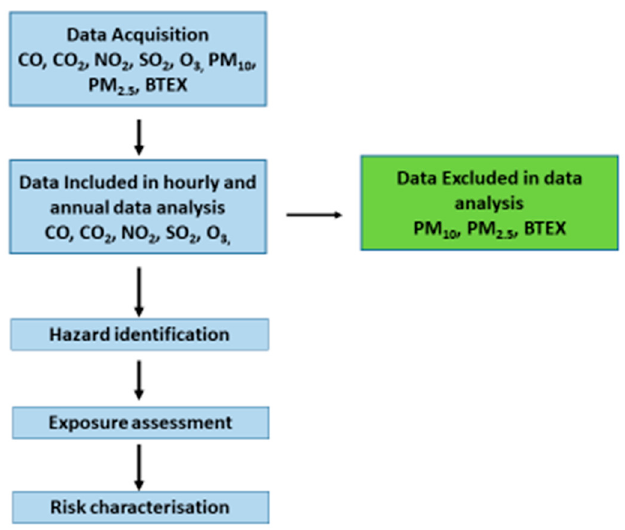
Figure 3. A flow chart of data type analysed and used for human health risk assessment.